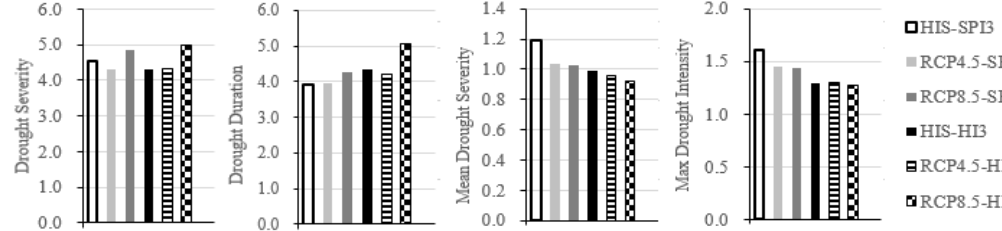
Figure 6. Statistical extreme drought characteristic values by SPI and HI in the past (1960–2015) and future (2020–2099)